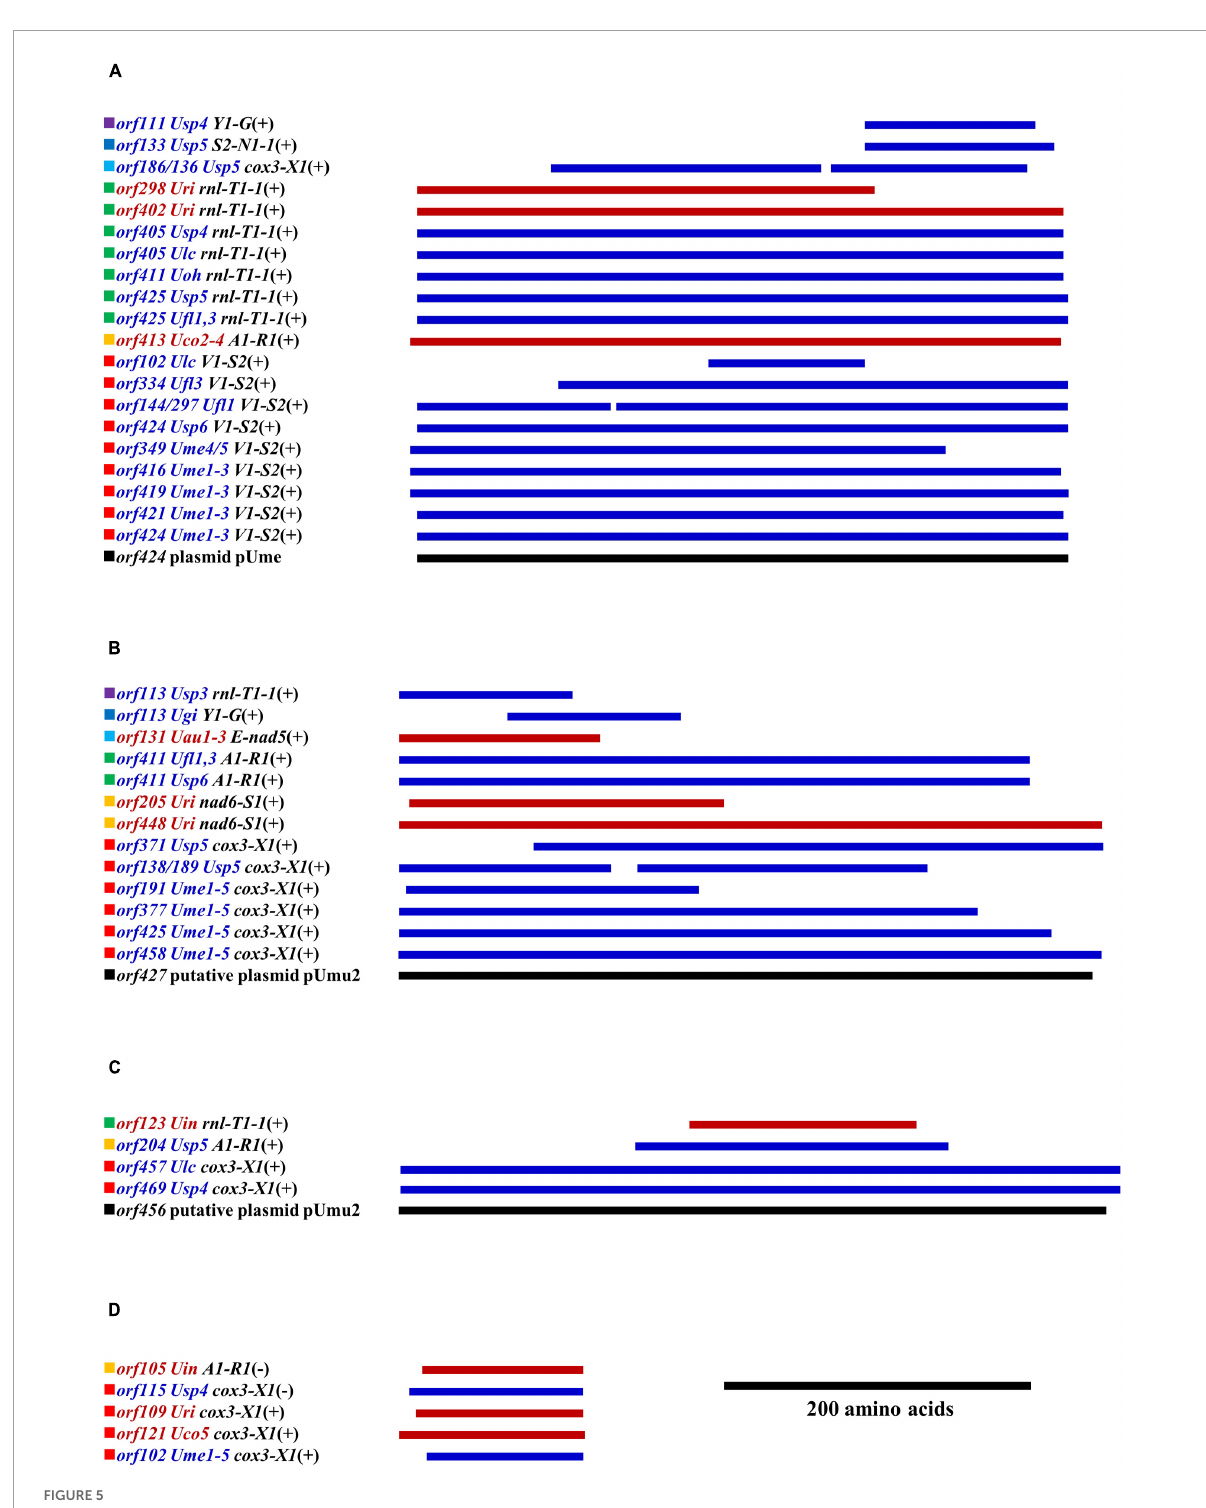
FIGURE5 Schematic alignments of specific free-standing orf s detected in all sequenced mitogenomes ( Supplementary Table 1 ) and putative circular plasmids of Ulva species. (A) Homologs of plasmid orf424 . (B) Homologs of putative plasmid orf427 . (C) Homologs of putative plasmid orf456 . (D) Homologs of orf102 . The solid squares with different colors represent different sources of specific orf s, including different intergenic regions (IRs) and putative plasmid. The orfs in blue font are from Ulva species in lineage I, and the orf s in red font are from Ulva species in lineage II. The orfs transcribed on the same strand as the core genes are marked with a positive sign (+), and the orf s transcribed on the minus strand are marked with a negative sign